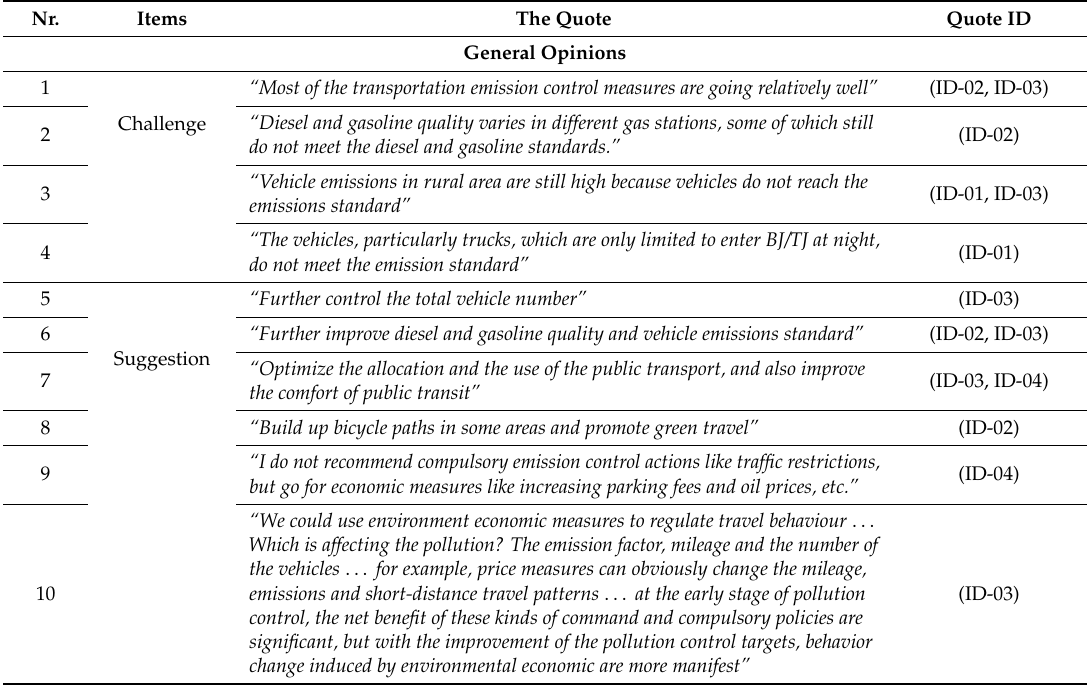
Table 2. Interview quotes on traffic emission